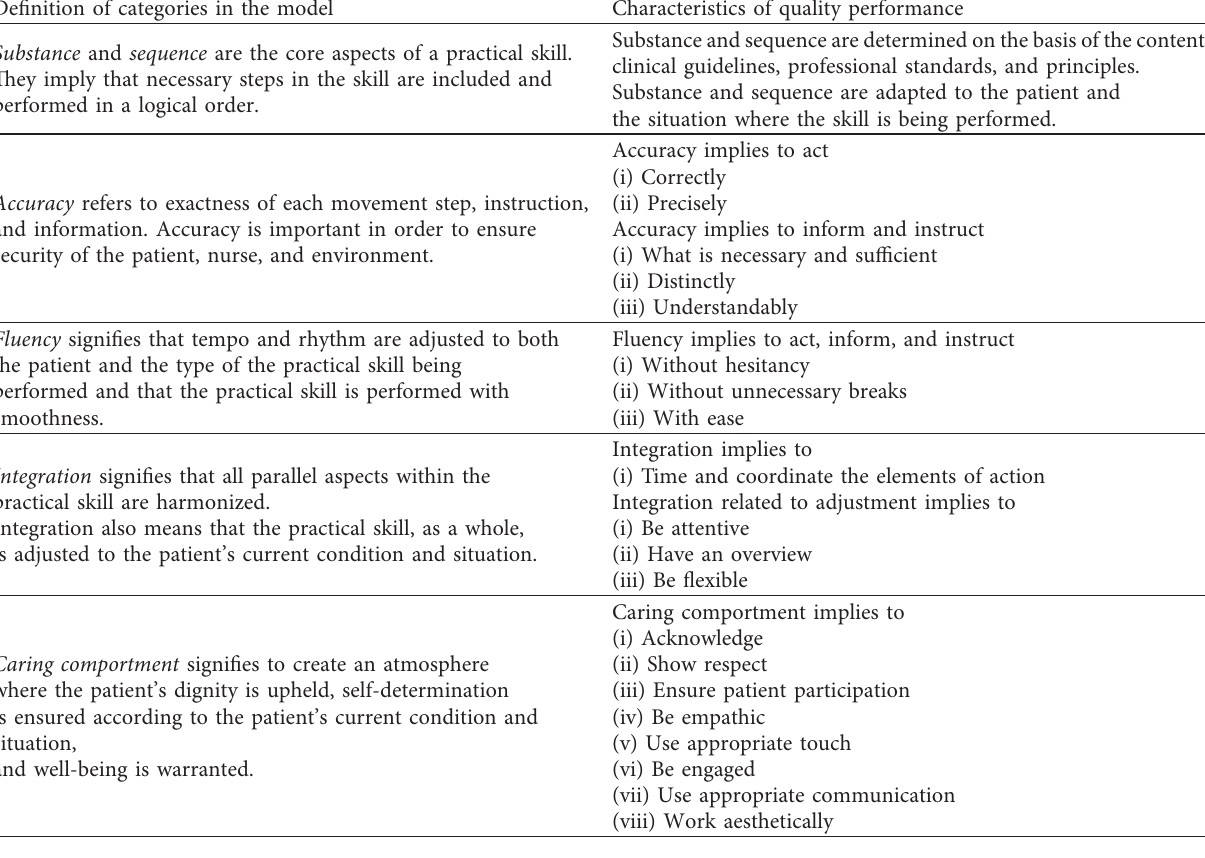
Table 1: Instrumental supplement to the Model of Practical Skill Performance (http://www.rins.dk). Definition of categories in the model